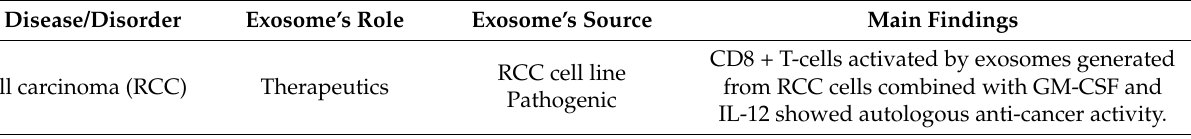
Table 4. Role of exosomes in renal diseases